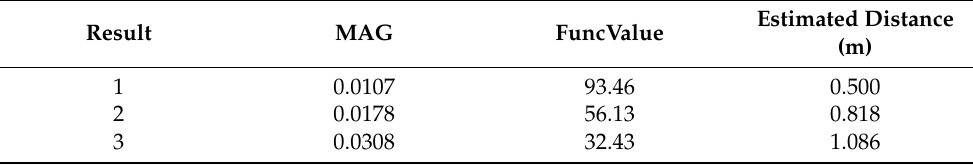
Figure 6. The one-dimensional line array imaging results. ( a ) Inversion results 1; ( b ) inversion results 2; ( c ) inversion results 3. Table 1. MAG of near-field imaging results at different estimated distances of one-dimensional line